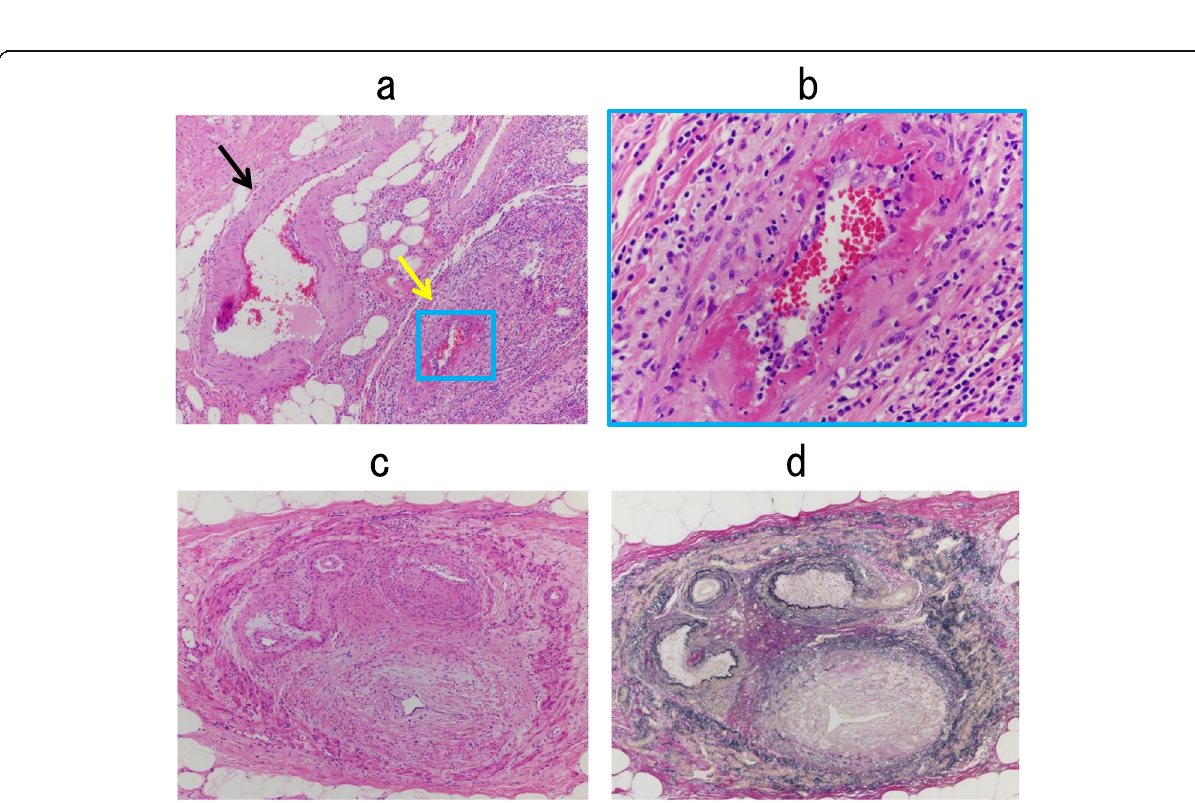
Fig. 10 The arteries and veins penetrating through muscularis propirae. Vein showing phlebitis with fibrinoid necrosis, but arteries were normal ( a , hematoxylin/eosin [HE] stain, black arrow: artery, yellow arrow: vein). Magnified image shows phlebitis with fibrinoid necrosis ( b , HE stain). A recanalized finding of a thick vein was observed at the subserosal layer ( c , HE stain). Prominent stenosis was observed in the recanalized vein ( d , Elastica van Gieson